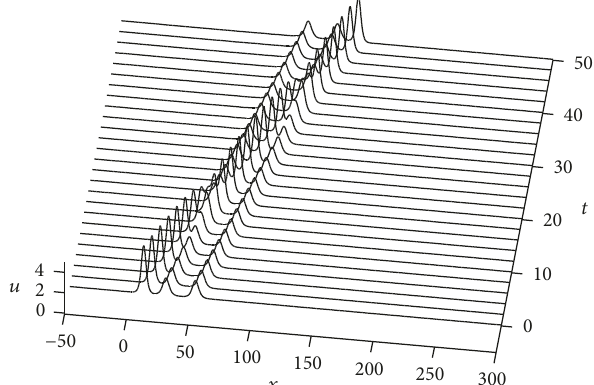
Figure 4: Example 2. The propagation process for the elastic collision of three solitary waves at different times with 𝑁 = 400 .